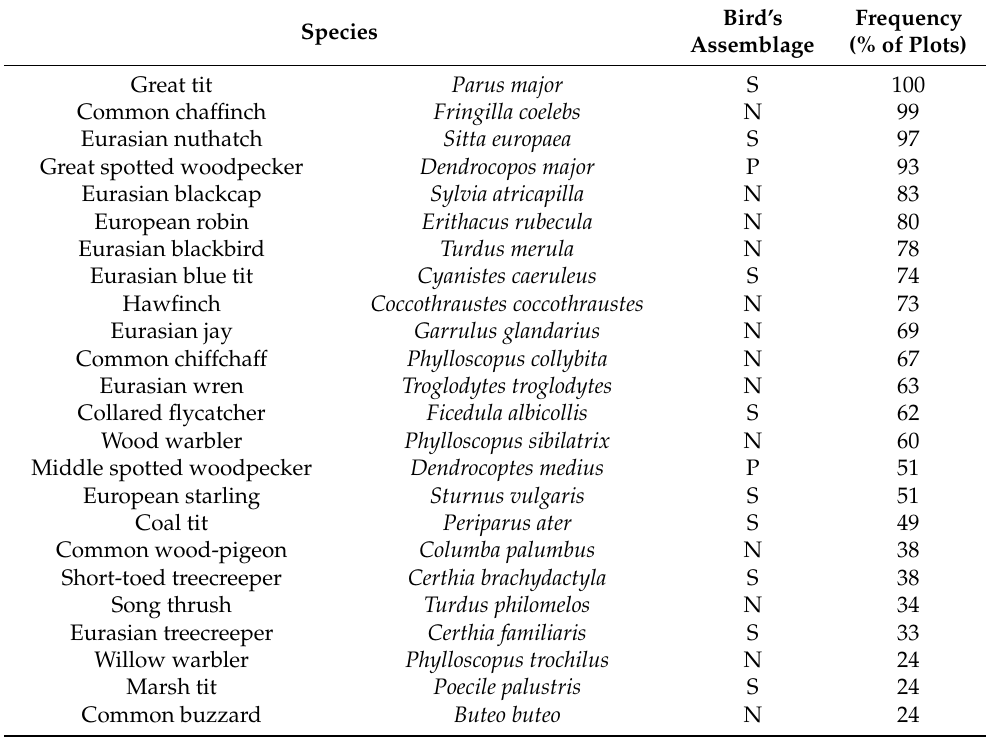
Table A1. Breeding bird community of the Niepołomice Forest. Results of four surveys in 94 plots at two-week intervals from early April to late May